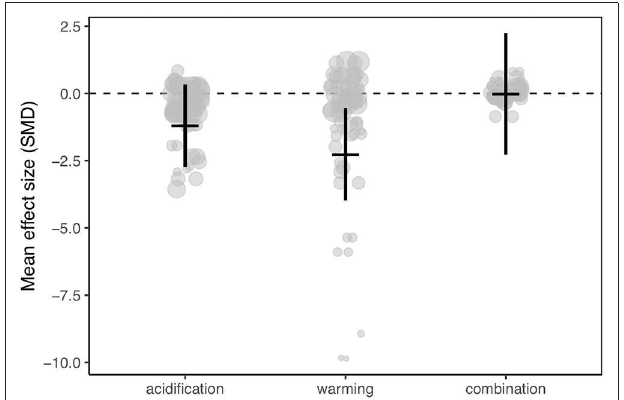
FIGURE 2 | Mean effect (standard mean difference) and 95% confidence interval of ocean acidification, warming, and the combination of acidification and warming on calcification rate for all studies in the meta-analysis. Gray circles indicate the effect size of each individual study and the size of each circle represents the weight of each study (1/SE). Clear statistical evidence of a treatment effect is identified when the 95% confidence interval does not overlap zero.